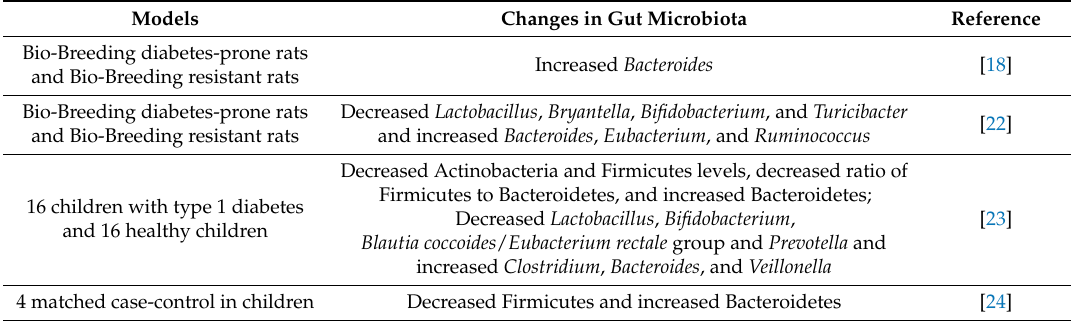
Table 1. Changes in gut microbiota of different models with type 1 diabetes or at risk of type 1